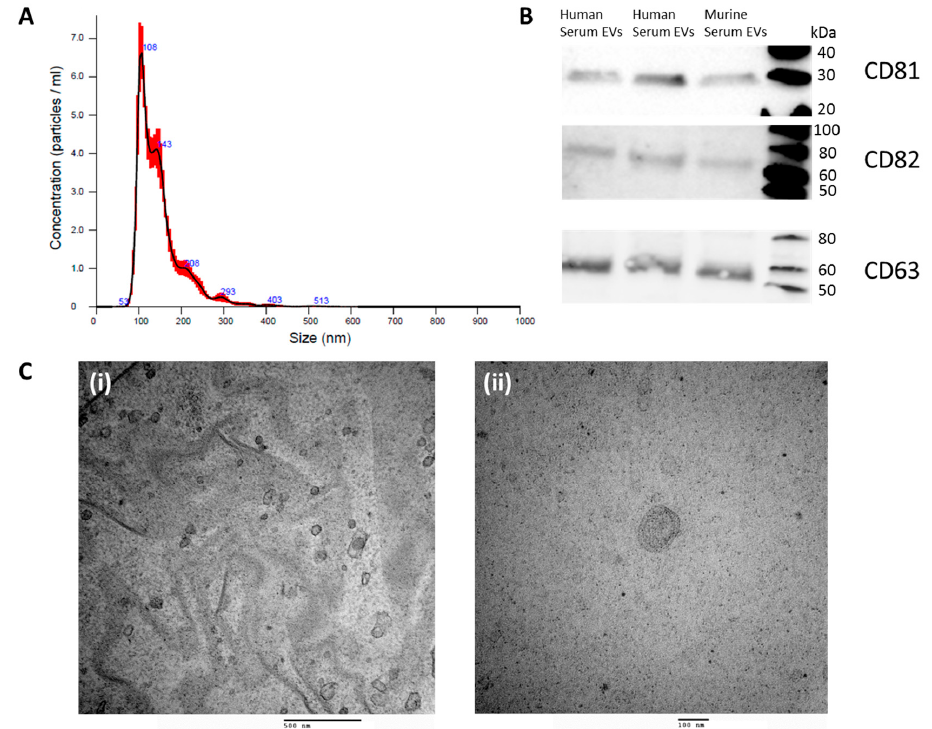
Figure 1. Serum extracellular vesicle characterisation: ( A ) Nanoparticle tracking analysis—the mean size distribution and concentration (1 × 10 9 ) of the particles. The line represents the average of five readings with red shading showing range across readings; ( B ) western blot analysis confirming the detection of CD81 (27–30 kDa), CD82 (60 kDa), and CD63 (50–60 kDa) at the appropriate band sizes. ( Ci ) TEM wide field view image (60,000×) and ( Cii ) close field view (120,000×) demonstrating EVs with a round morphology and lipid bilayer.